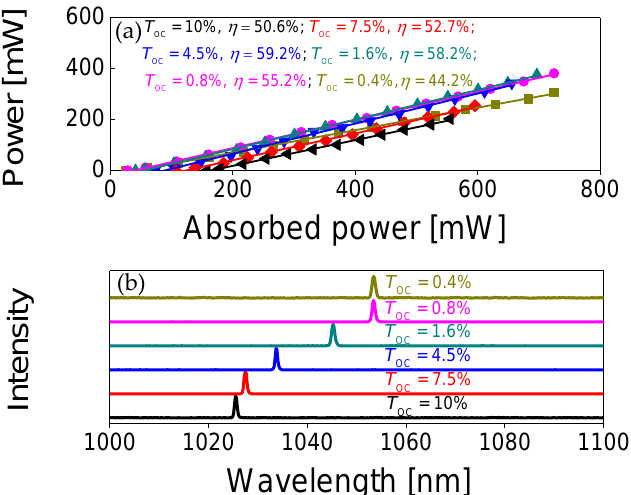
Figure 2. CW laser performance of a -cut Yb:GdCB crystal: ( a ) input – output dependences for different transmissions of the OC ( T OC ) and the η — slope efficiency; ( b ) laser spectra. The laser polarization was E ‖ c .